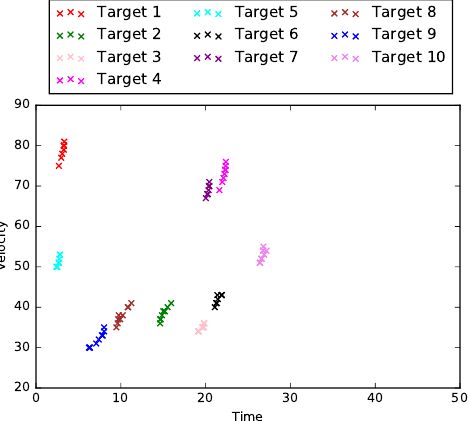
Figure 3. Example of preprocessed X 1 for a single road